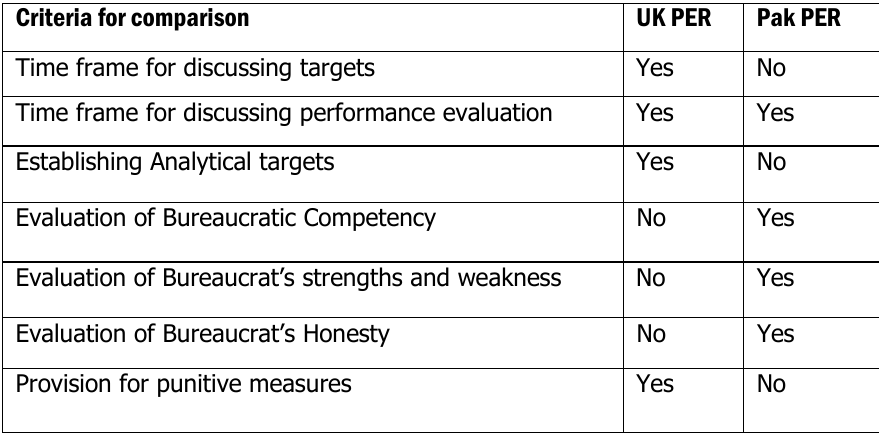
Table 1: Comparison of the British SMART System and Pakistani Performance Evaluations Reports (PER) Criteria for comparison UK PER Pak PER Time frame for discussing targets Yes No Time frame for discussing performance evaluation Yes Yes Establishing Analytical targets Yes No Evaluation of Bureaucratic Competency No Yes Evaluation of Bureaucrat’s strengths and weakness No Yes Evaluation of Bureaucrat’s Honesty No Yes Provision for punitive measures Yes